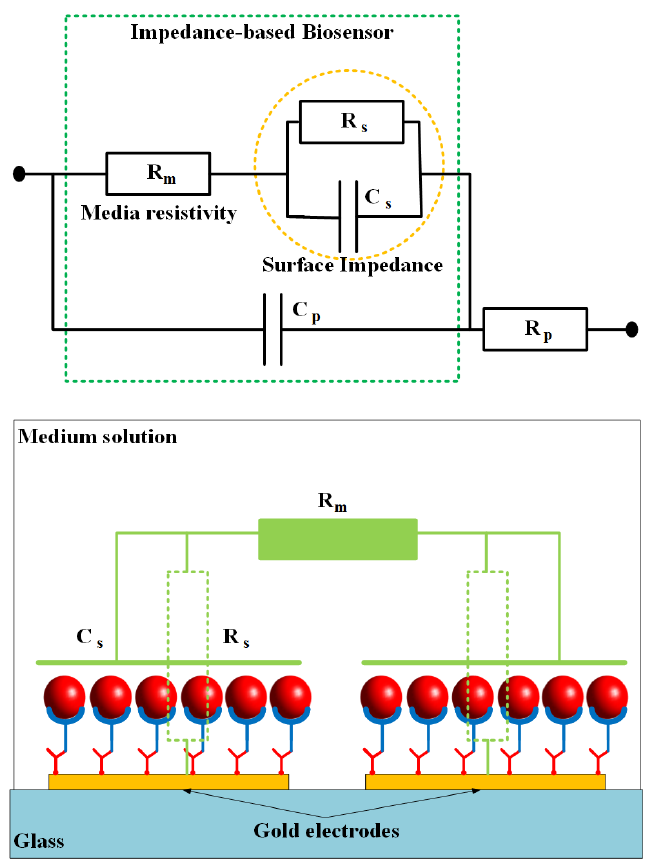
Figure 7. An electrical equivalent circuit model of biosensor based on impedance measurement method. The impedance is constructed of two main parts: surface impedance and resistance of salt media (PBS).